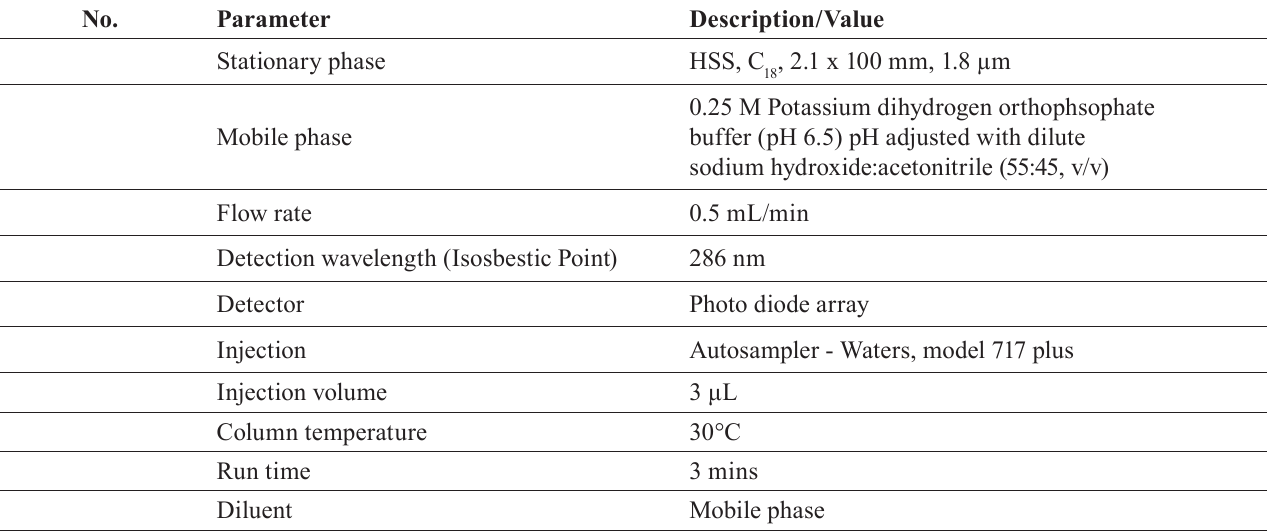
TABLE I - O ptimized chromatographic conditions for the estimation of FOS and PAL